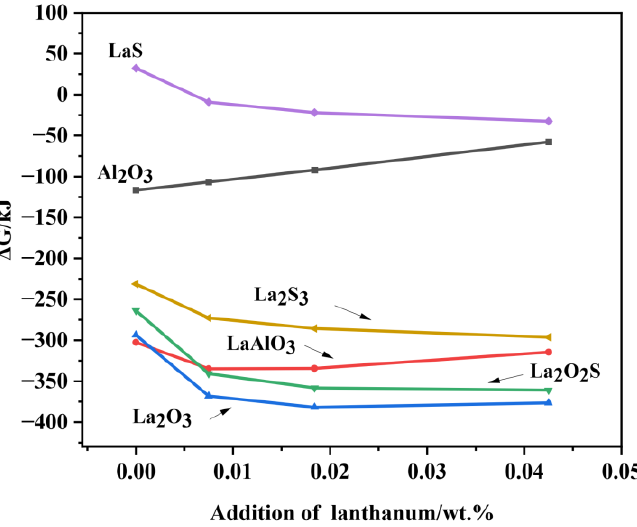
Figure 13. Diagram of inclusion predominance region in steel with different La contents at 1600 ◦ °C.